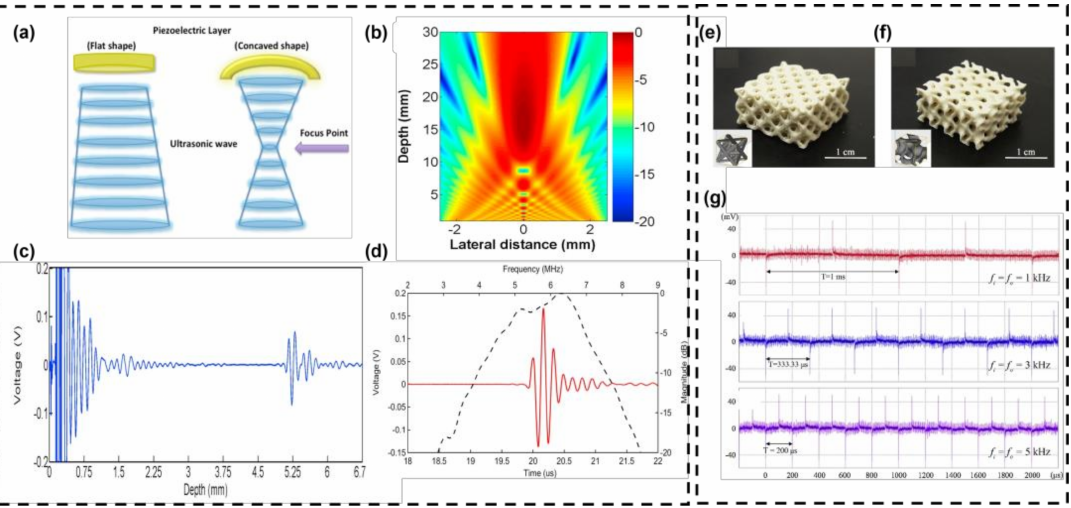
Figure 6. ( a ) The schematic diagram of the non-focused and focused transmit beam generated by the ultrasonic transducer. ( b ) Beam profile simulation by Field II program. ( c ) Initial pulse and echo generated by the printing-focused transducer. ( d ) Pulse-echo waveform (solid line) and normalized spectrum [59]. ( e , f ) The complex-structured BTO ceramics and composites are fabricated by the DLP process. ( g ) The output signal waveforms when changing the input signal frequency